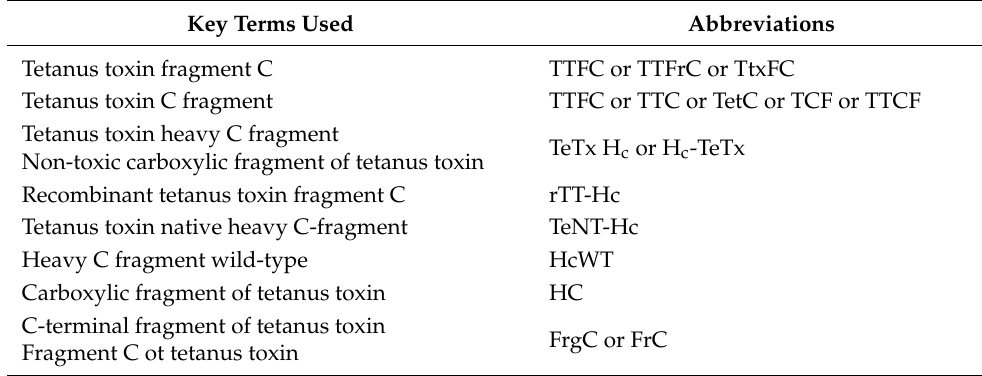
Table 1. Terms and abbreviations used in association with tetanus toxin fragment C.